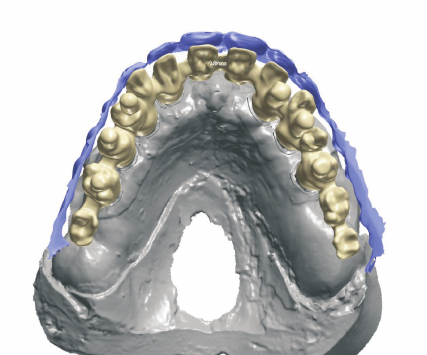
Figure 9: Computerized view of model and metal